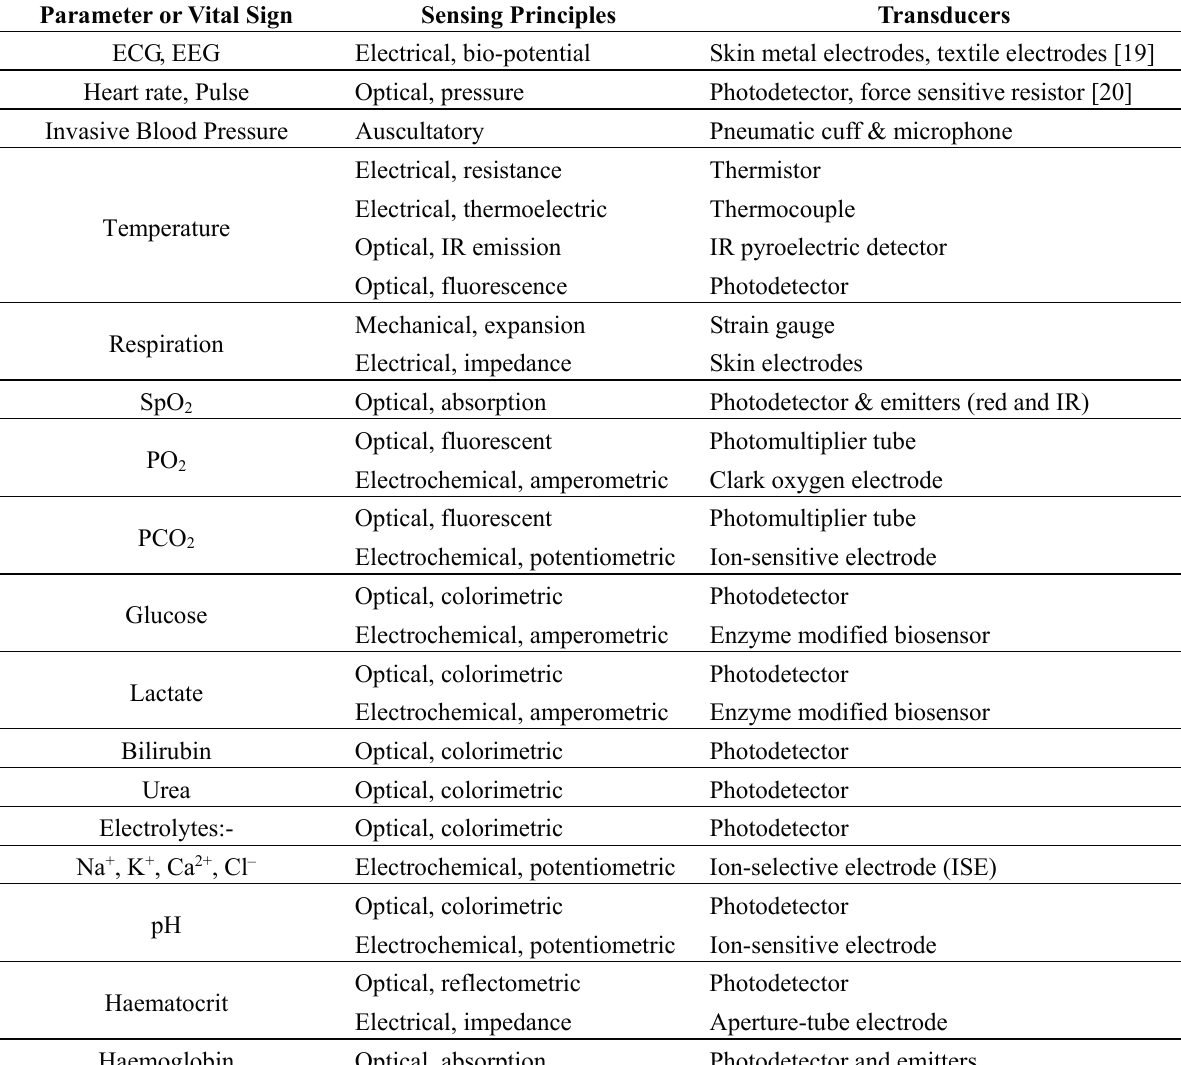
Table 1. The main physiological vital signs and parameters monitored during neonatal intensive care, with relative sensing principles and